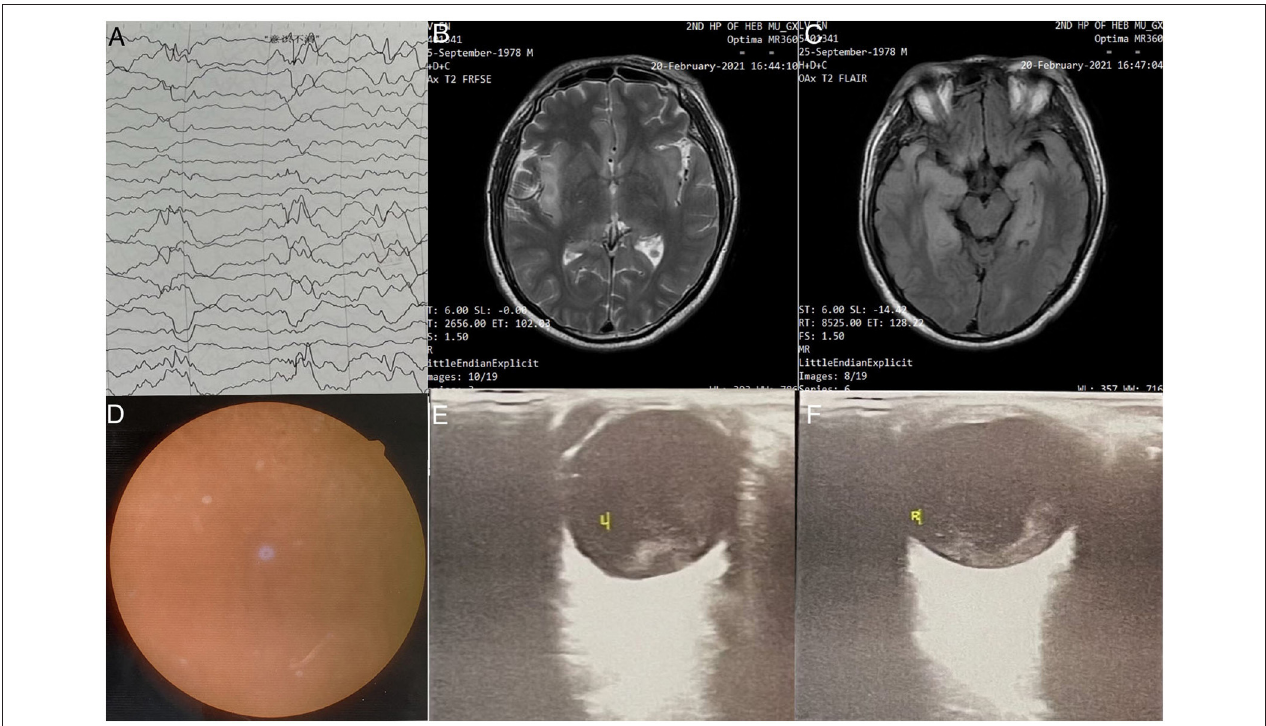
FIGURE 1 | (A) Electroencephalography findings: Severe abnormal diffuse mixed slow waves with a lot of fast waves, intermittent low-voltage waves, lasting about 1s, diffuse 1-2Hz irregular s activity, left sharp waves and sharp slow waves are emitted from the front side of the head; (B) Head MRI - T2 FRFSE: Bilaterally symmetrical abnormal signals are observed in the anterior cingulate gyrus; (C) Head MRI - T2 FLAIR sequence: Symmetrical abnormal signals of insula and fronto temporal lobes; (D) Fundus examination: Both eyes have clear cornea with no hyperemia, anterior chambers, pupil diameter of ∼ 3mm, slow reflection of light; (E) Ophthalmic ultrasound-L: (1) Severe vitreous opacity; (2) Thickening of the posterior wall of eyeball; (3) Thickening of the four rectus muscles of the eyes; (F) Ophthalmic ultrasound-R: (1) Severe vitreous opacity; (2) Thickening of the posterior wall of eyeball; (3) Thickening of the four rectus muscles of the eyes. The ring of the right eye is intact, the lens wave is visible, and the dark area can be seen in the vitreous body. There is medium to high amount of diffuse flocculent weak echo and cluster echo. The posterior wall of the ball is thickened and slightly rough. The thickness of the superior rectus, external rectus, inferior rectus, and medial rectus is ∼ 5.9, 5.6, 5.6, and 6.4mm,